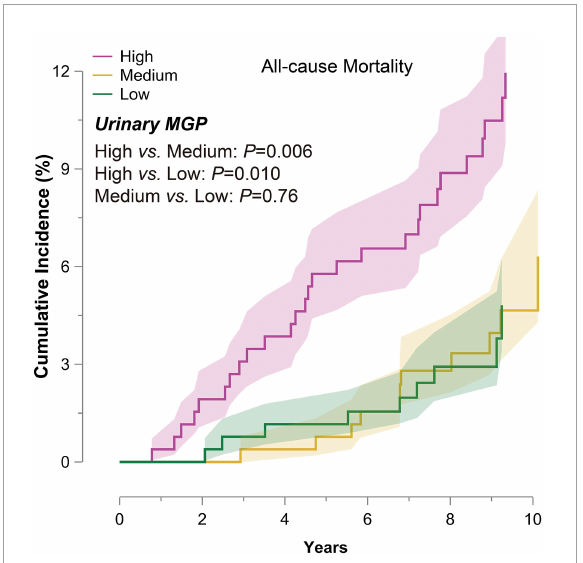
FIGURE1 Cumulative incidence of all-cause mortality in 776 participants by one-third of urinary matrix Gla protein (MGP). The participants were divided into the three groups by one-third of urinary MGP. The colored bands represent SE. P -values express the significance of the log-rank test for the difference across one-third of urinary MGP. Abbreviation: MGP, matrix Gla protein; SE, standard error.